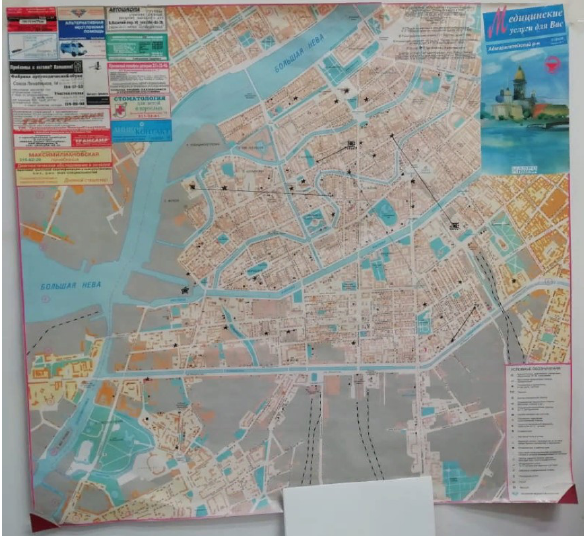
Figure 2. Graphical user interface of prototyped geocoding module for